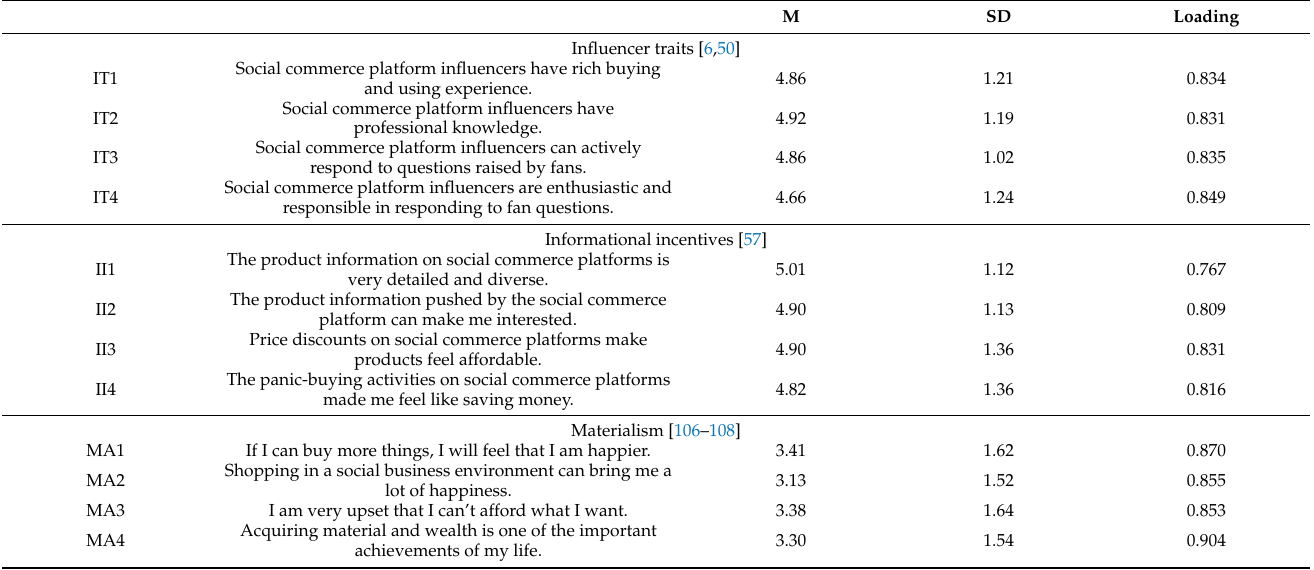
Table A1. Instrument and measurement